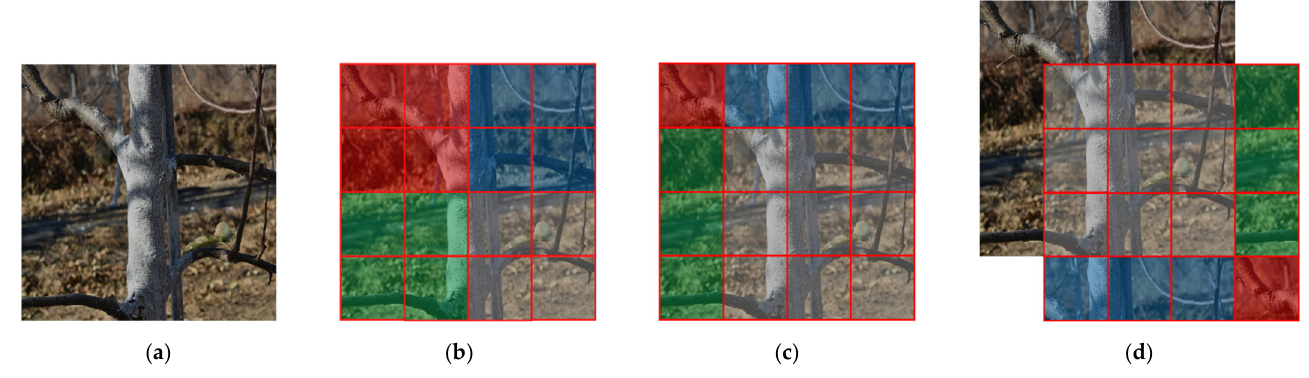
Figure 5. Shifted windows based on self-attention mechanism: ( a ) input image; ( b ) W-MSA segmen- tation method; ( c ) SW-MSA segmentation method; ( d ) shifted windows.